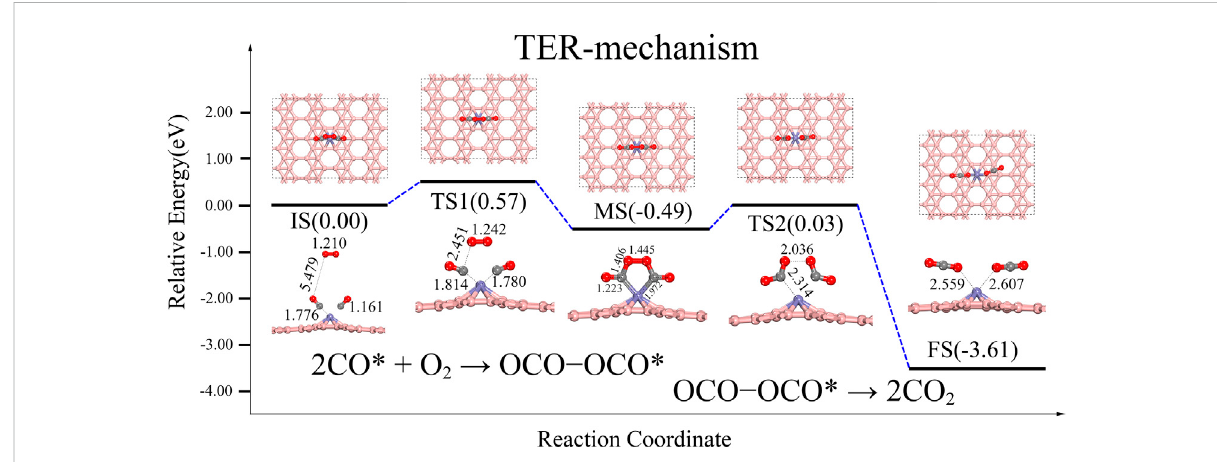
FIGURE 4 Energy distribution diagram under TER path and its corresponding structure diagram, the rate-determining step is IS-MS2 turning over an energy barrier of about 0.57